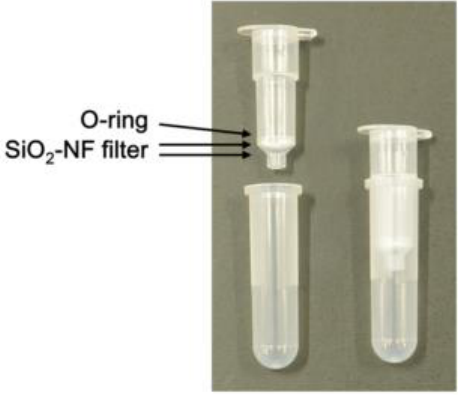
Figure 2. Spin columns with SiO 2 -NF filters for the removal of leucocytes and platelets from whole blood. Two sheets of SiO 2 -NF filters were set on an empty column and fixed with an O-ring (left). The column was set on a collection tube (right).